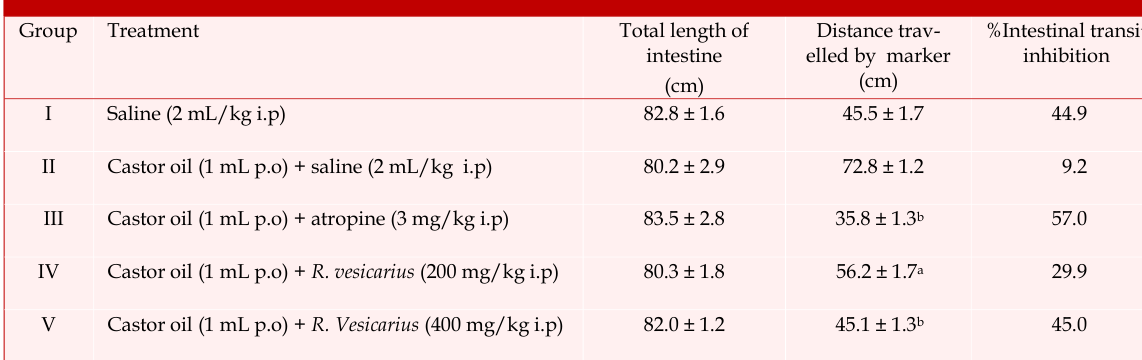
Effect of R. vesicarius on castor oil-induced small intestinal transit in rats